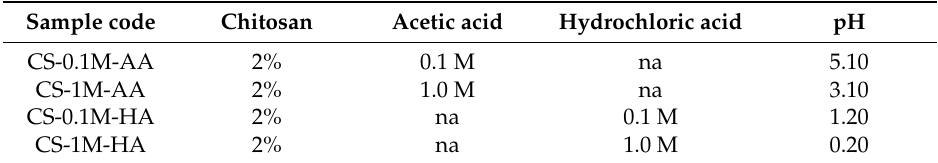
Table 1. Sample codes, compositions and pH of the resulting